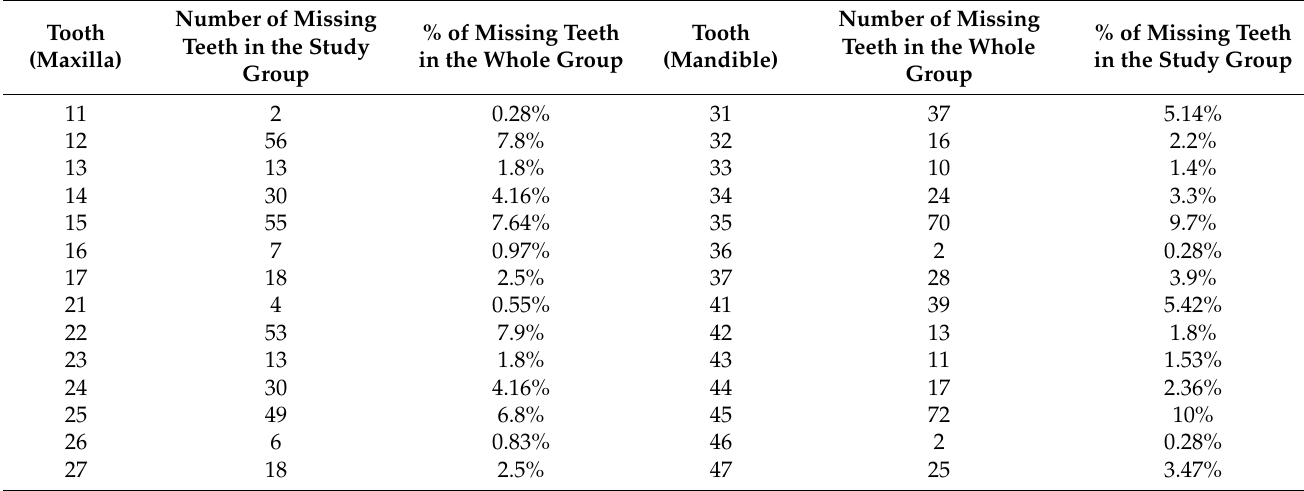
Table 4. The distribution of missing teeth in the study group.